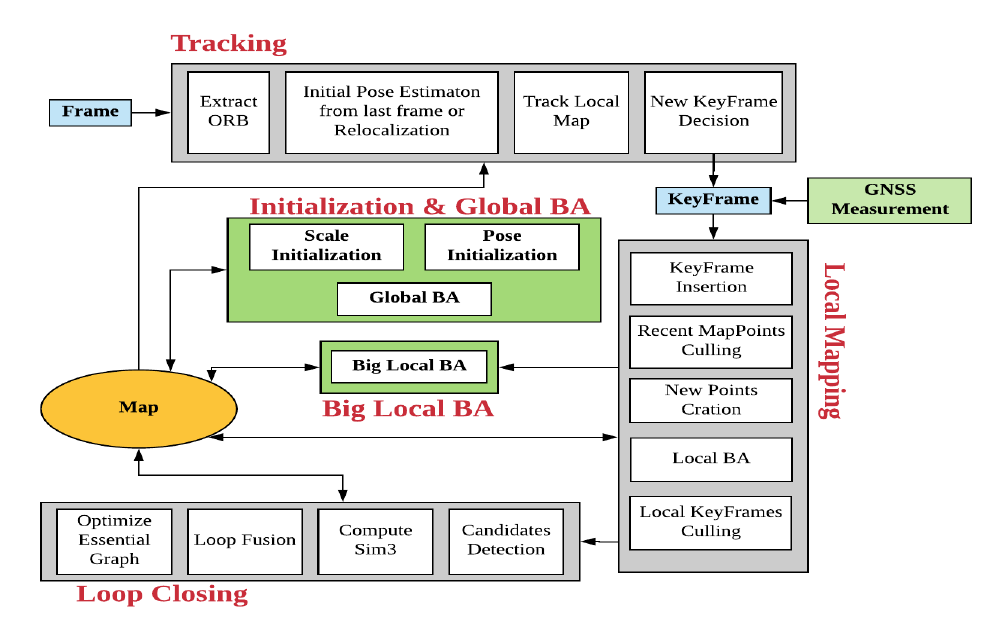
Figure 1. Global Navigation Satellite System–visual-ORB–simultaneous localization and mapping (GVORB) system overview. The gray modules represent the threads of the original ORB-SLAM. The green modules are the new threads in